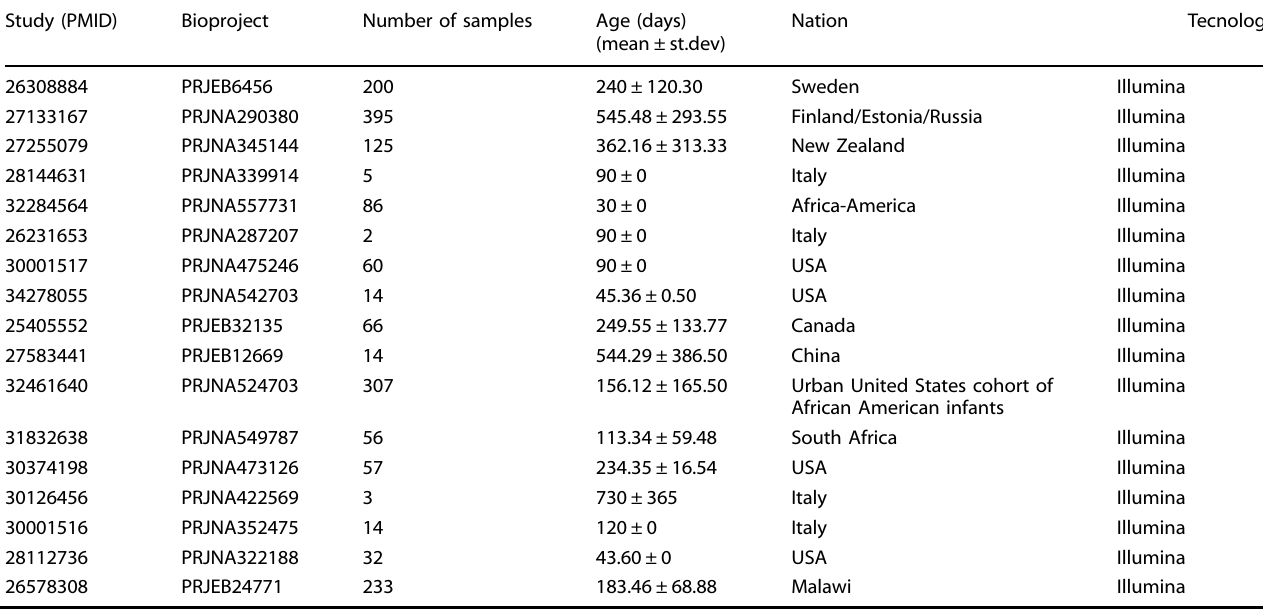
Table 1. Metadata associated to the fecal samples included in this